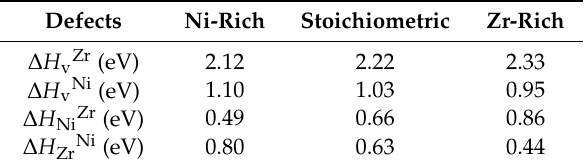
Table 2. Theoretical effective formation energies for point defects in Zr 7 Ni 10 at 1000 ˝ C.